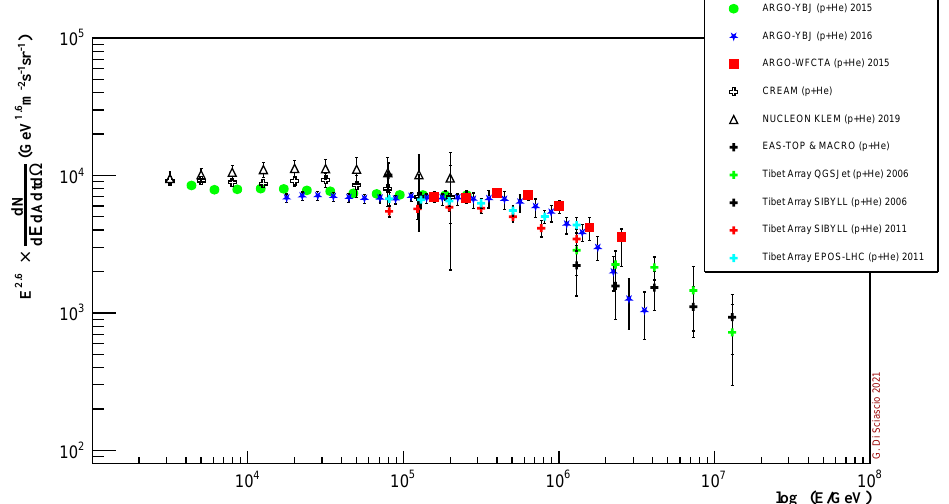
Figure 5. Energy spectra of the light (p+He) component as measured by Tibet AS γ [25,31] and ARGO–YBJ [52] experiments with different techniques and analyses, compared with results obtained in direct observations by CREAM [57] and NUCLEON